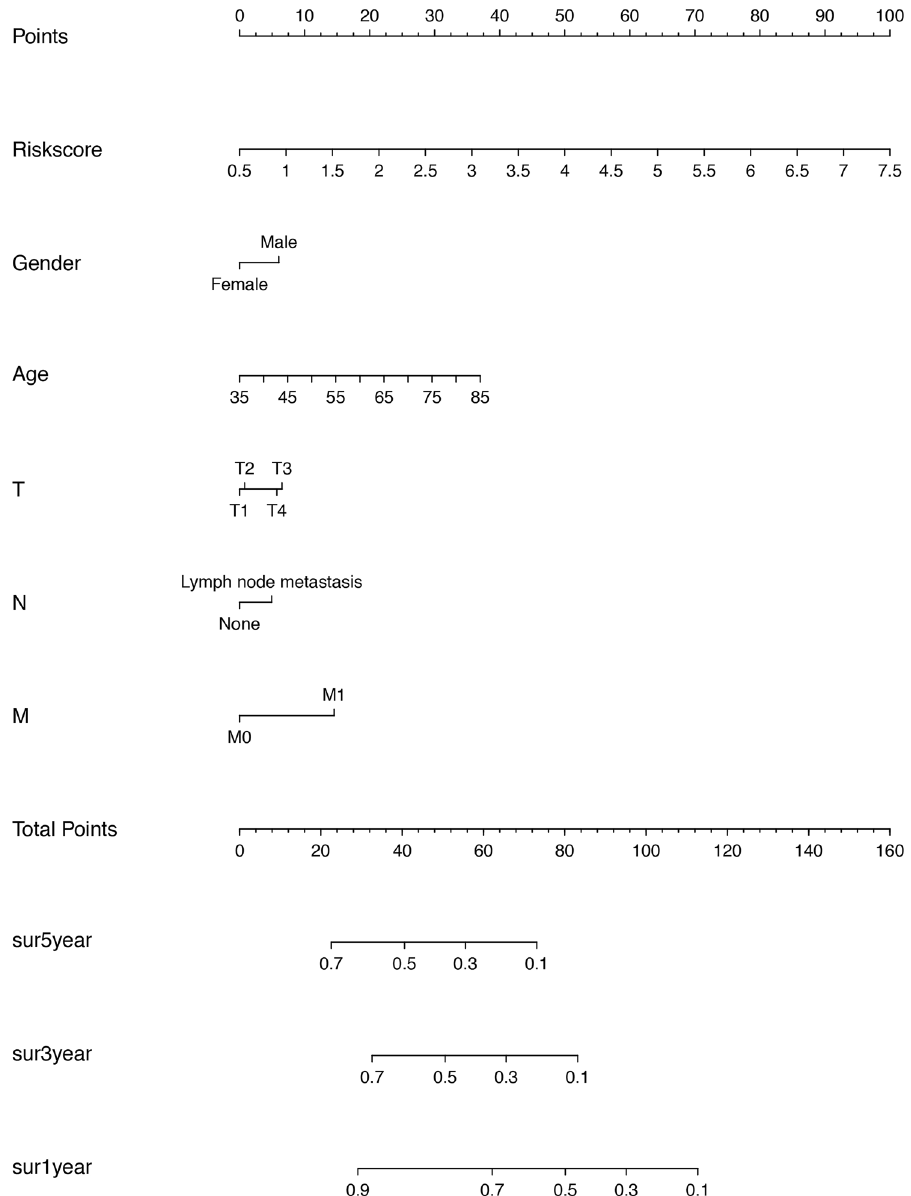
Figure 6. A prognostic nomogram predicting 1-, 2-, and 3-year overall survival of LUSC